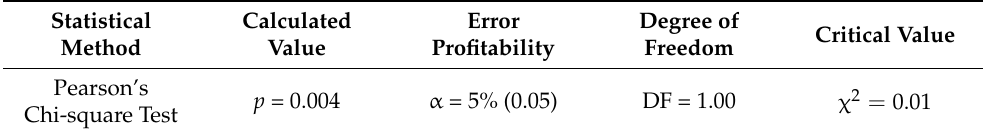
Table 3. The results of testing 2 hypothesis using the Pearson’s Chi-square test of independence. Source: Own processing.